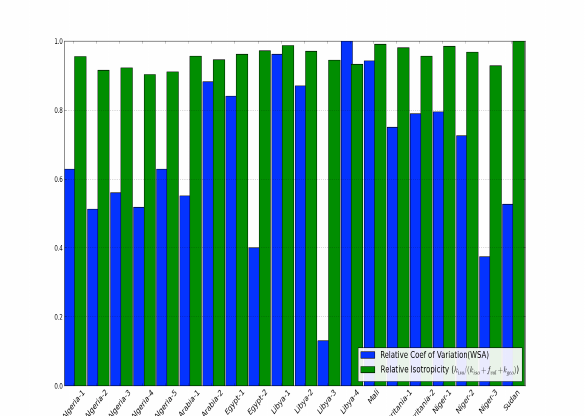
Figure 6. Relative (to the maximum) isotropicity index and relative coefficient of variation (relative to the